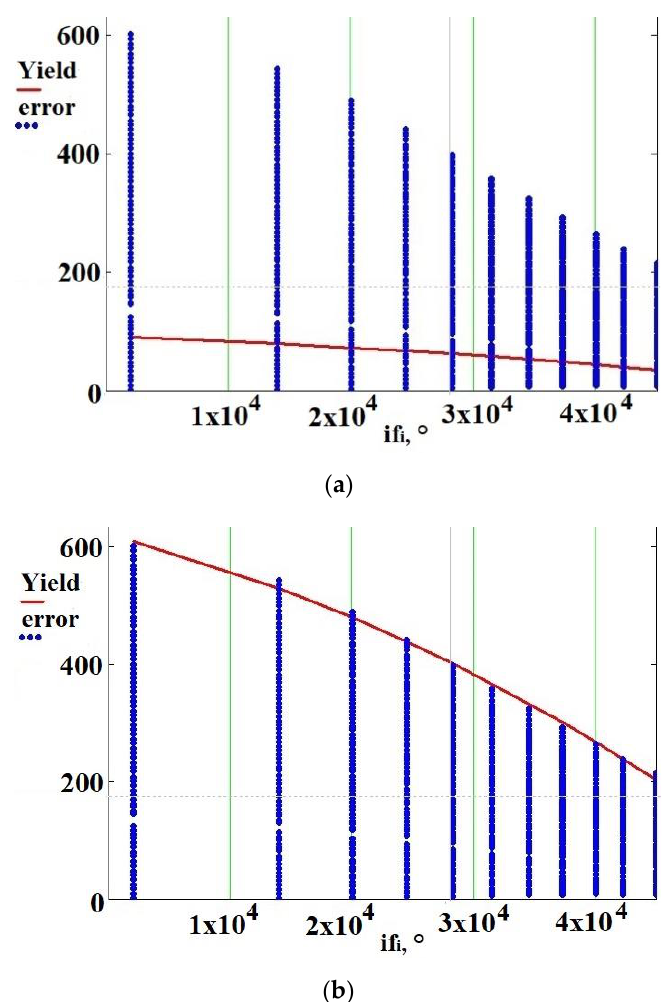
Figure 11. Desired signal amplitude (error) dependency on magnetic field strength (phase shift if i ) with fixed nozzle temperature: ( a )110 °C, ( b )750 °C.